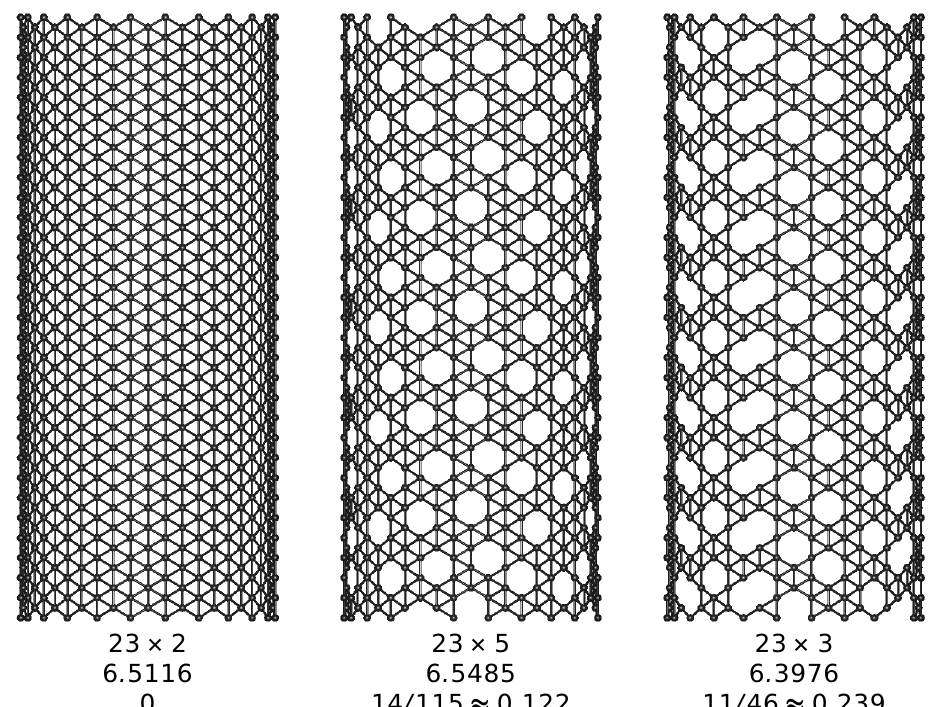
Figure 3. Examples of BNTs with three different hole densities. For each nanotube, the n φ and n z parameters, which describe the unit-cell size, are provided. To obtain the same height of the nanotubes, the 2, 5, and 3 values of n z are multiplied by 15, 6, and 10, respectively (for a total height of 50.25 Å). The binding energy, E b , and hole density, η , are also